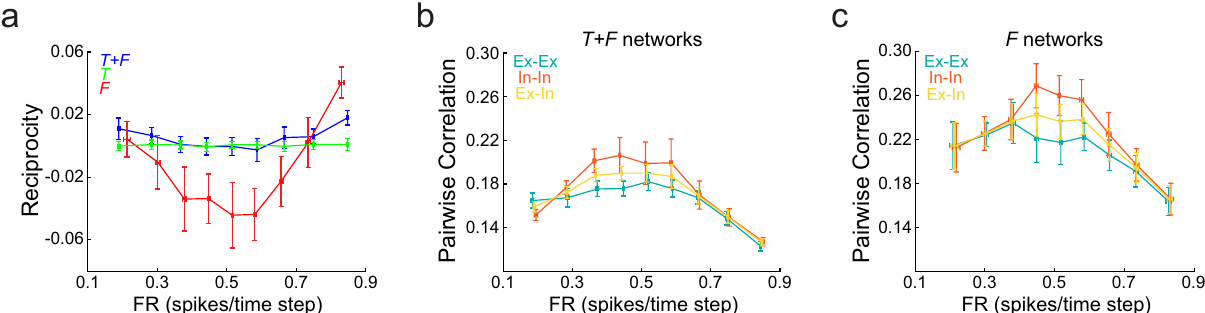
Figure 7. Reciprocity and correlation of structurally constrained networks. ( a ) Reciprocity as a function of FR for networks without self-connections and Dale’s principle with 1:1 Ex:In ratio. Reciprocity shows a parabolic relationship with FR, decreasing as FR approaches 0.5 spikes/time step. F networks show strong negative reciprocity, while T networks reciprocity is close to zero. ( b ) Pairwise correlation for T + F networks as a function of firing rate. The correlation was computed over pairs of excitatory neurons (Ex-Ex), pairs of inhibitory neurons (In-In), and pairs of one excitatory and one inhibitory neuron (Ex-In). Correlation has a maximum close to 0.5 spikes/time step. The In-In pairs show the highest correlations, followed by the Ex-In pairs. The Ex-Ex pairs show the lowest correlation. ( c ) pairwise correlation for F networks as a function of firing rate. The CC/FR relationship is similar to the one observed for T + F networks, although F networks correlation is displaced towards higher values. Mean ± SD are shown; n = 20 networks were constructed for each target FR and network type. Firing rates of excitatory or inhibitory neurons are displayed for Ex-Ex and In-In curves, respectively. For Ex-In curves, the average FR over all neurons is